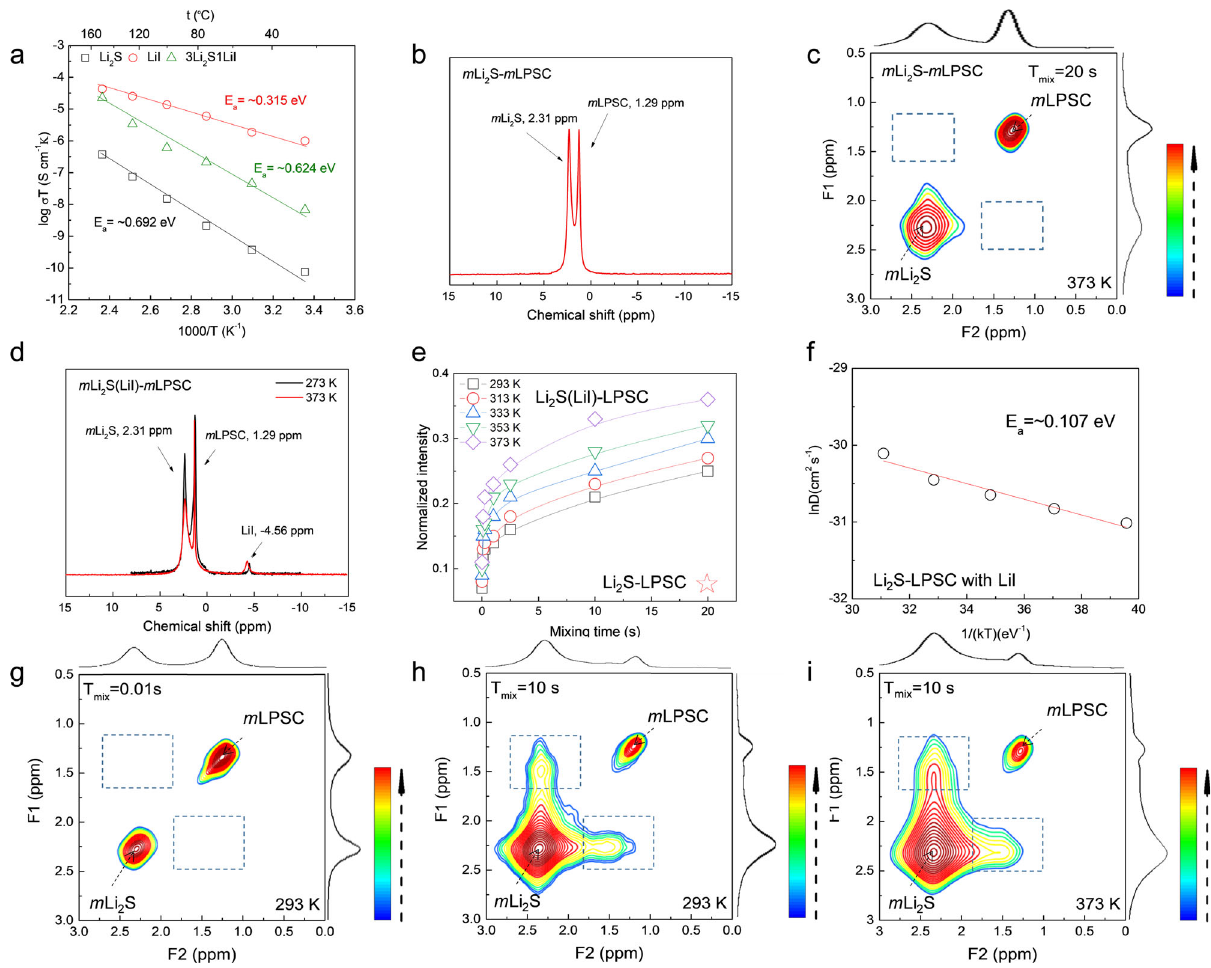
Fig. 3 Li-ion conductivity of the positive electrode and quanti fi cation of the Li + exchange across the electrode-solid electrolyte interface. a Ionic conductivity determined by impedance spectroscopy of pellets of Li 2 S, LiI, and the Li 2 S-LiI mixture at different temperatures. b , c One-dimensional (1D) 6 Li magic angle spinning (MAS) and two-dimensional (2D) 6 Li – 6 Li exchange (2D-EXSY) NMR spectra of the mLi 2 S-mLPSC cathode mixtures at a mixing time of 20 s, where Li 2 S and LPSC are both micron-sized. No obvious off-diagonal cross-peak intensity is observed, indicating that the exchange of Li + over the